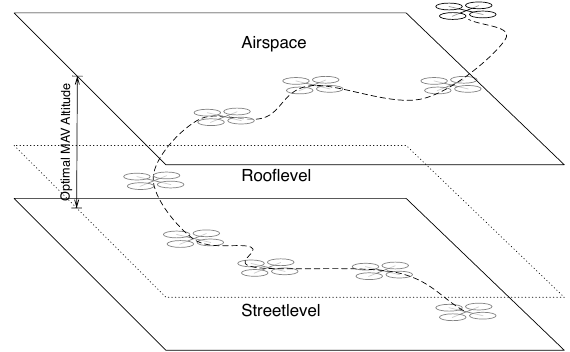
Figure 1: Optimal MAV operational altitude between street level and roof level. This range is not accesible for UAVs or hand-held